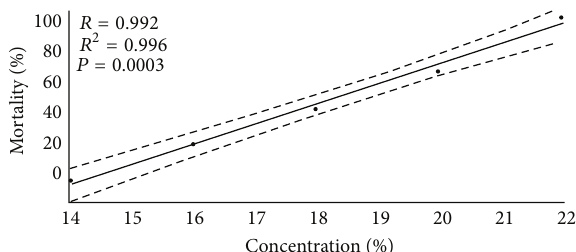
Figure 3: Correlation between the concentration of the extract and the mortality of